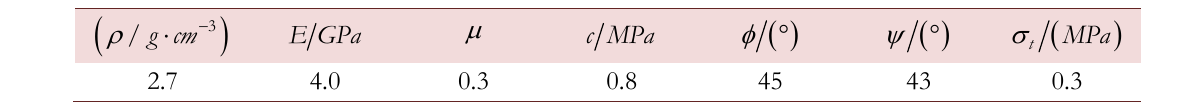
Table 1: The Children's Palace foundation rock physics parameters